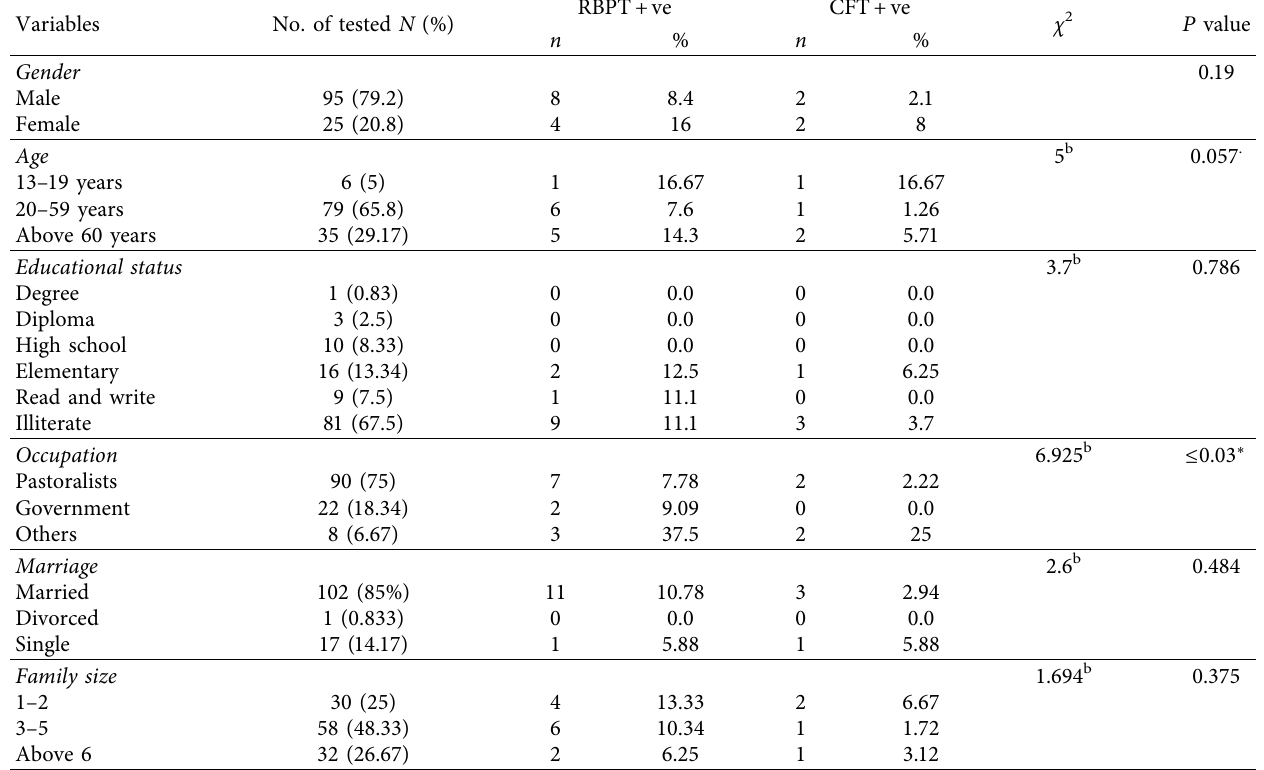
Table 4: Sociodemographic characteristics and Brucella seroprevalence among the study participants.